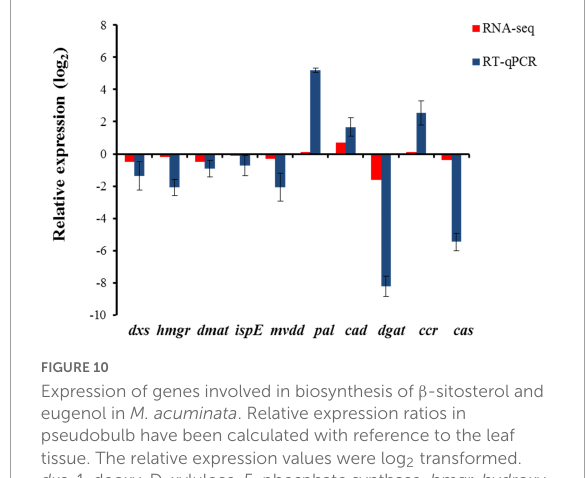
FIGURE10 Expression of genes involved in biosynthesis of β -sitosterol and eugenol in M. acuminata . Relative expression ratios in pseudobulb have been calculated with reference to the leaf tissue. The relative expression values were log 2